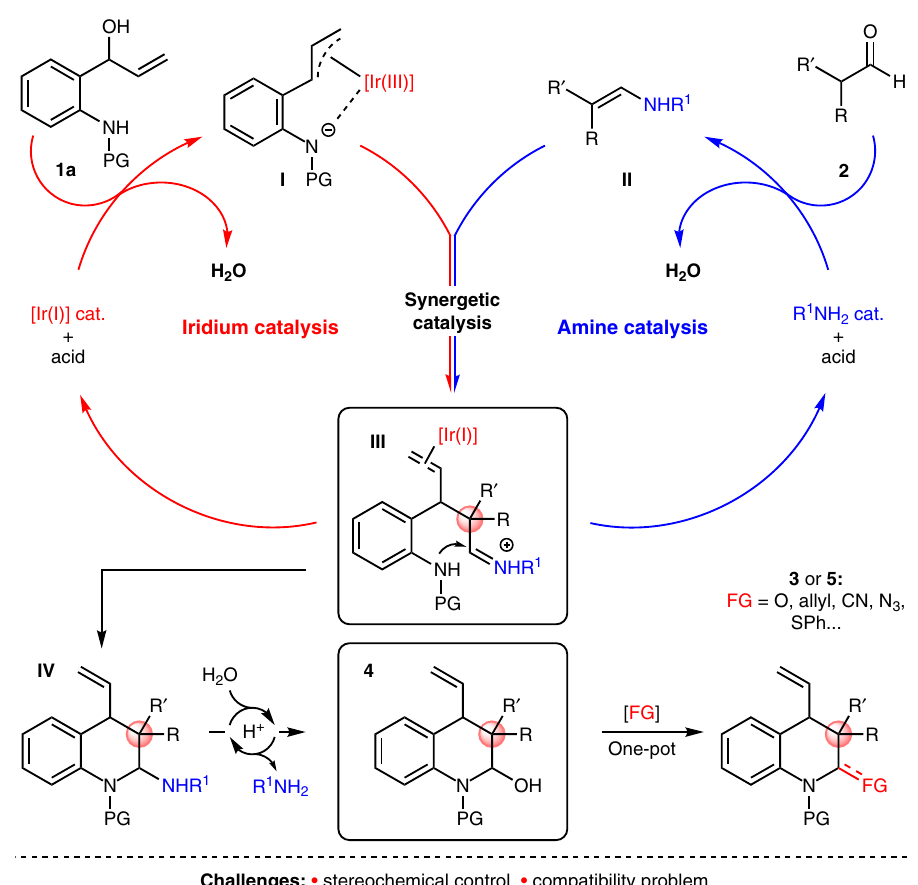
Fig. 2 Proposed mechanism. Synergetic iridium/amine catalysis for the enantioconvergent syntheses of